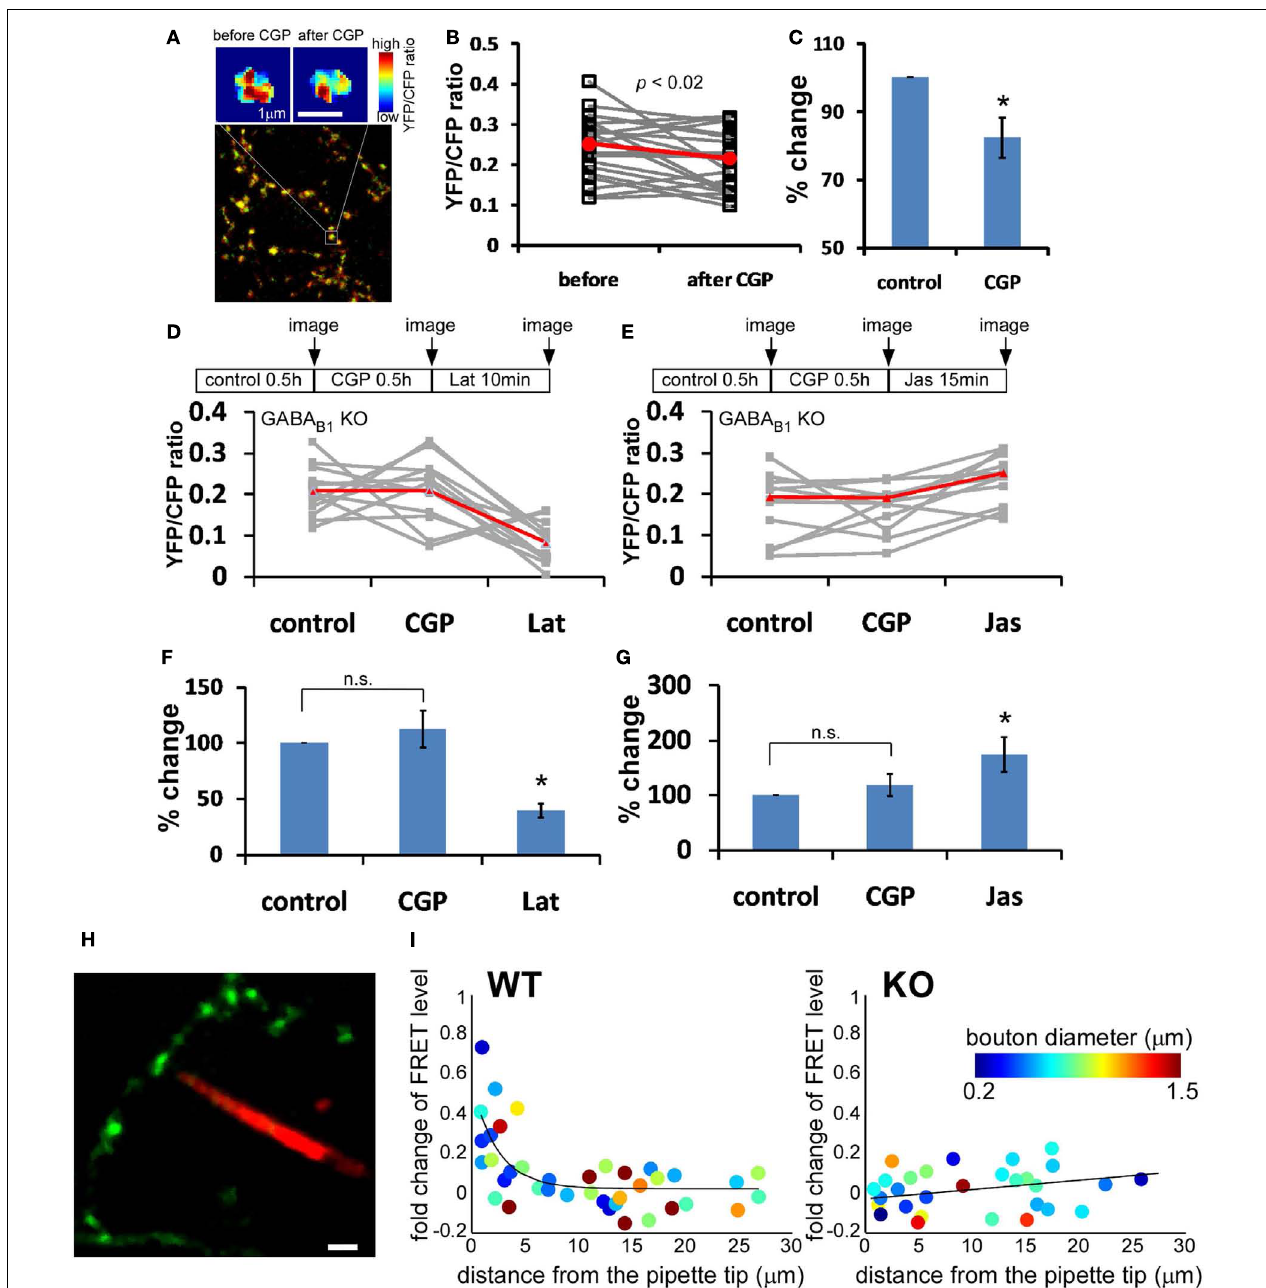
in GABA B1flx/flx ::PV-ires-Cre slice cultures were labeled by LSL-actin-YFP and LSL-actin-CFP .The change inYFP/CFP ratio of each bouton was followed under different drug treatments as indicated (gray lines). Red line is the average across all boutons. Latrunculin A (10 µ M, 10min) or Jasplakinolide (10 µ M, 15min) was added under the presence of CGP. Percent changes inYFP/CFP ratio were normalized to control condition ( n = 12 from three cells; one-way repeated measures ANOVA, Bonferroni post hoc test, P < 0.005 for Lat vs. CGP, P < 0.01 for Jas vs. CGP). (H) Representative image of two-photon imaging-guided placement of iontophoresis pipette tip to close vicinity of a single bouton. (I) The change of FRET level after focal iontophoresis of GABA, plotted against the distance between individual bouton and pipette tip ( n = 6 cells for bothWT and KO). Solid lines are fitted curve with y = a × exp( − x / b